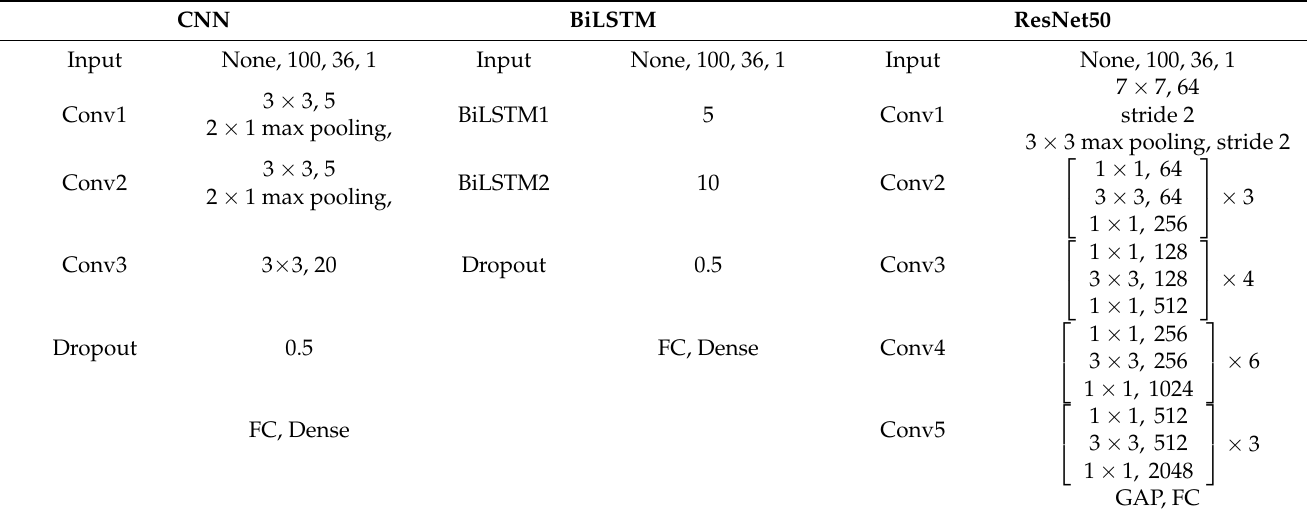
Table 4. Instantiation of deep learning